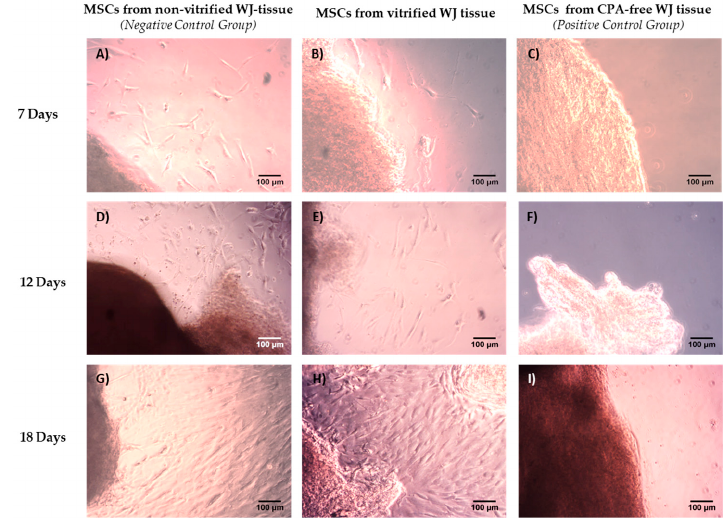
Figure 1. Isolation of MSCs derived from non-vitrified, vitrified and CPA-free WJ tissue. MSCs derived from fresh non-vitrified WJ-tissue (n = 10) at day 7 ( A ), 12 ( D ) and 18 ( G ). MSCs derived from vitrified WJ tissue (n = 10) at day 7 ( B ), 12 ( E ) and 18 ( H ). No MSCs were able to be isolated from CPA-free (n = 10) WJ tissue at day 7 ( C ), 12 ( F ) and 18 ( I ). Original magnification 10×, scale bars 100 μ m.